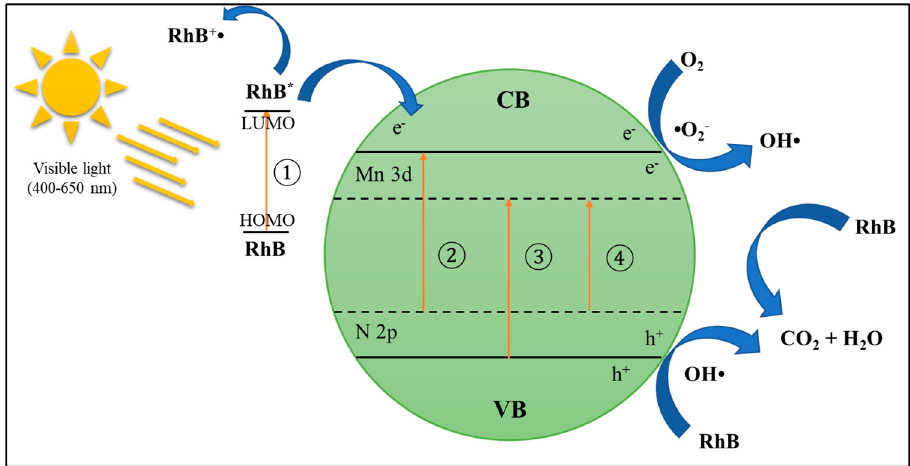
Figure 20. Schematic illustration for photocatalytic degradation of RhB over Mn-N-codoped TiO 2 under visible light irradiation.